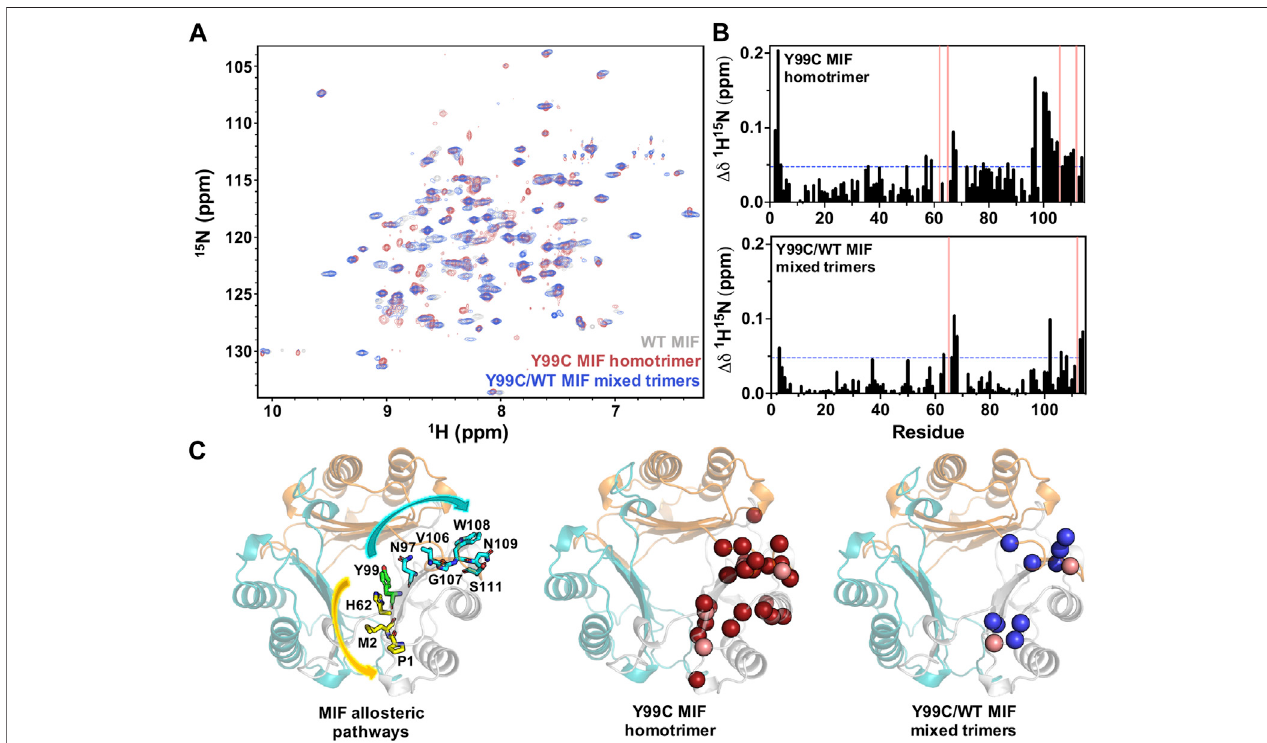
FIGURE 4 | (A) 1 H- 15 N TROSY HSQC spectral overlay of WT MIF (gray), the Y99C homotrimer (red), and the Y99C/WT mixed trimers (blue) (B) 1 H- 15 N combined chemical shift perturbations ( Δδ ) for the Y99C homotrimer (top) and the Y99C/WT mixed trimers (bottom). Pink bars denote residues that are broadened beyond detection,andbluelinesrepresent1.5 σ abovethe10%trimmedmeanofallshifts (C) Signi fi cantchemicalshiftperturbationsobservedfortheY99Chomotrimer(middle, red spheres) and Y99C/WT mixed trimers (right, blue spheres) are mapped onto the MIF structure (PDB: 1MIF) for comparison to the previously characterized MIF allosteric pathways (left) affecting tautomerase activity (yellow) and CD74 activation (teal). Pink spheres denote residues broadened beyond detection. Residues after position 99 are mapped onto the adjacent monomer, as reported for the CD74 activation site.